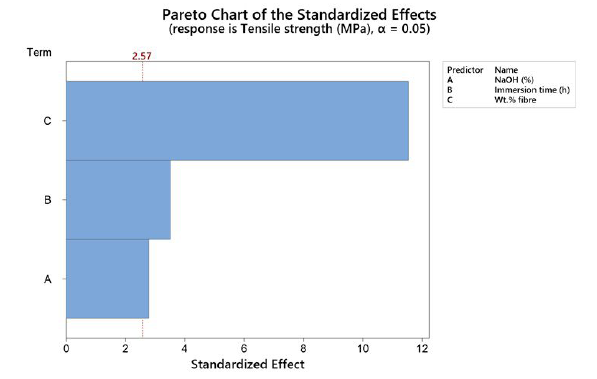
Figure 9. Pareto chart of the standardized